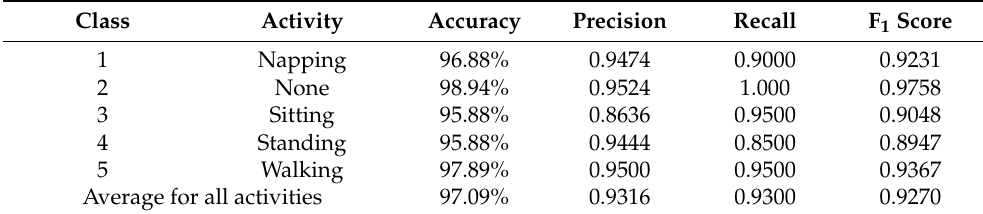
Table 7. Occupancy activity detection model performance based on the application of images from the testing dataset.